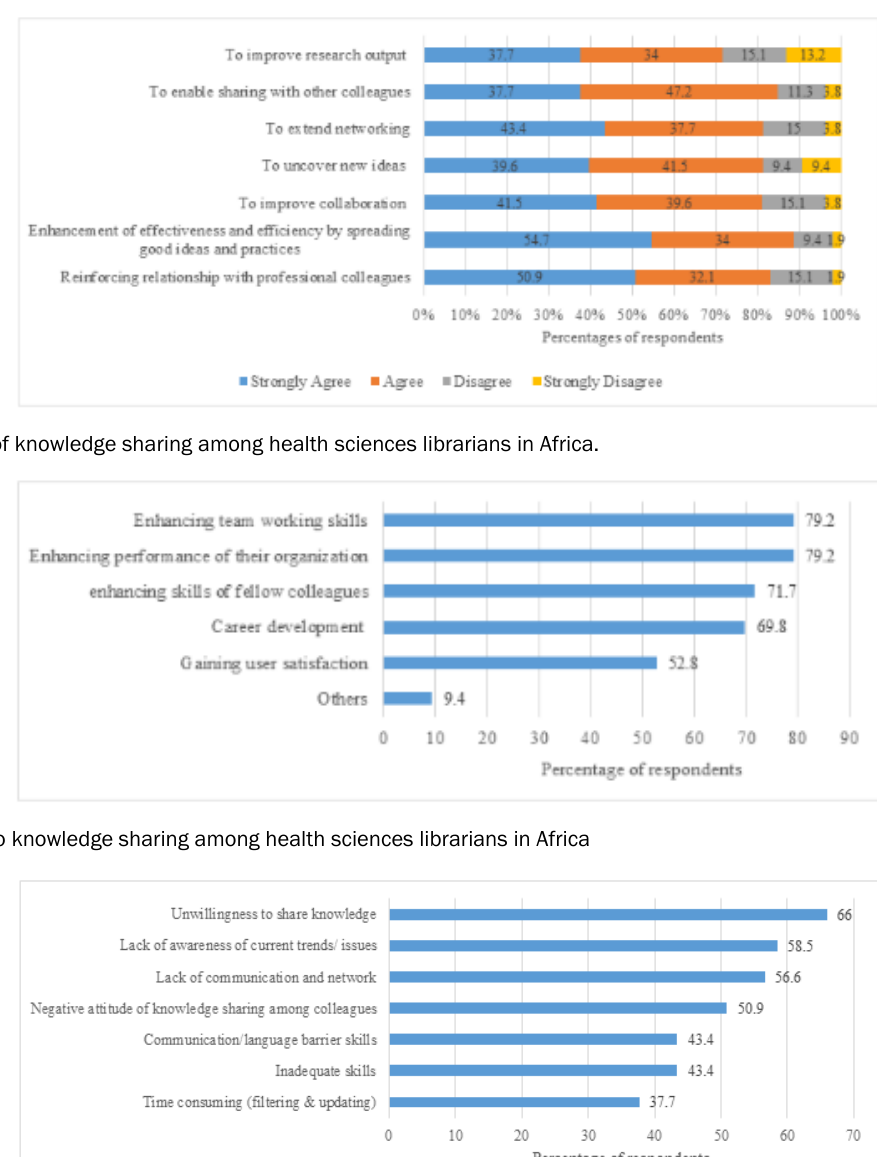
Figure 2 Purposes of knowledge sharing among health sciences librarians in Africa.